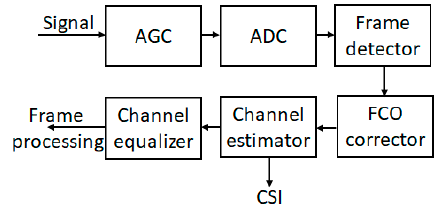
Figure 8. Typical receiver block diagram.